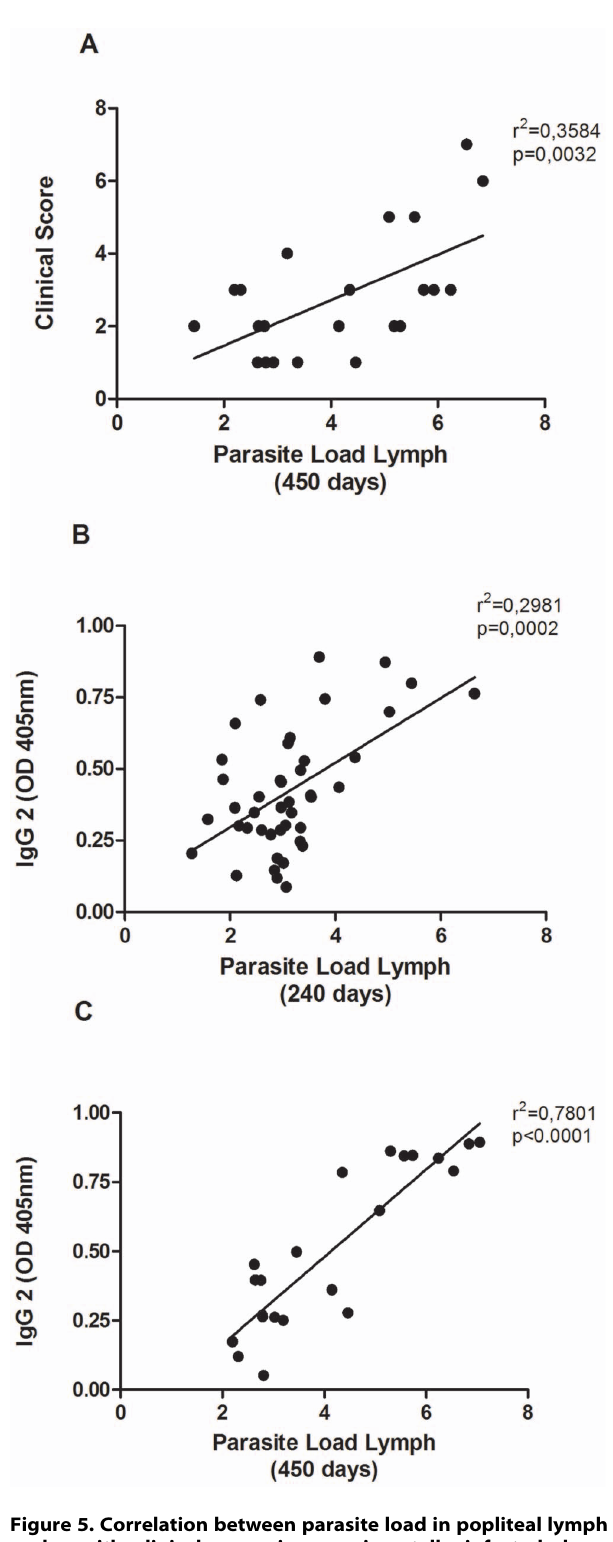
Figure 5. Correlation between parasite load in popliteal lymph nodes with clinical score in experimentally infected dogs. Correlation of Spearman between parasite load at popliteal lymph nodes with clinical score after 450 days of infection (A) and levels of IgG2 240 and 450 days after infection (B and C).